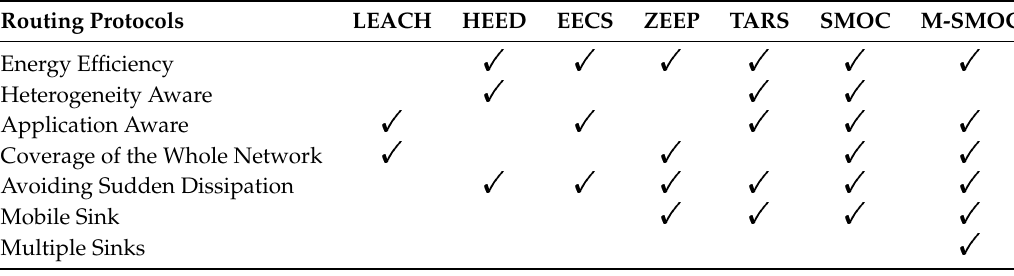
Table 3. Comparison of the characteristics of the proposed protocols with the existing state-of-the-art routing